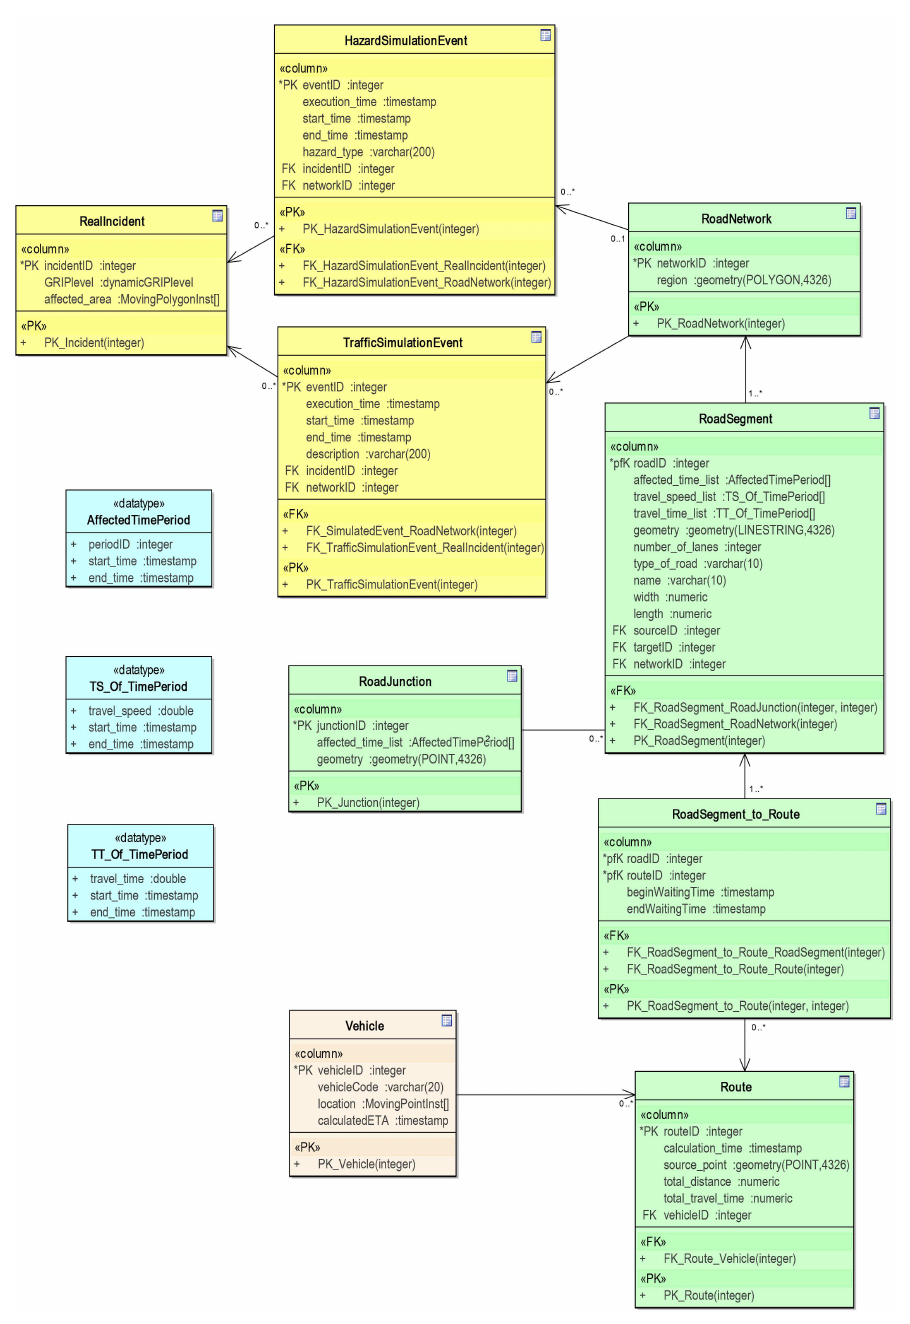
Figure 2. Logical data model for storing the traffic time